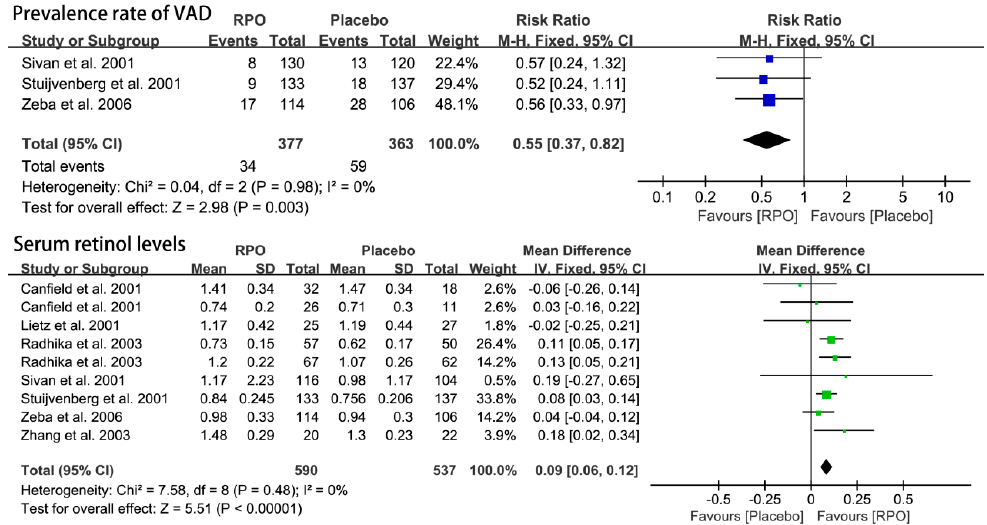
Figure 2. Forest plot of the effect of red palm oil (RPO) supplementation on the prevalence rate of vitamin A deficiency (VAD) and serum retinol levels ( μ mol/L) (RPO group vs. placebo group). CI: confidence interval.